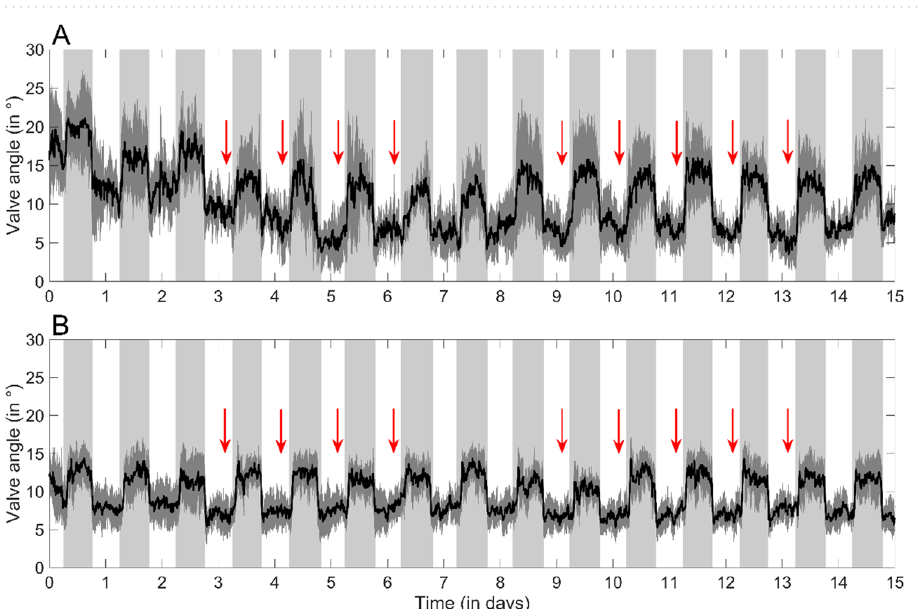
Figure 4. Scallops decrease valve angle during pile driving events, with no acclimation over long (i.e., days) and short (i.e., minutes to hours) time. Responses (valve angle, in degrees) from tagged scallops to PD at two different time scales at the near site: ( A ) Mean changes in valve angle in response to daily PD (black lines) compared to the preexposure sequence (dashed line). The red line highlights the mean of 9 days of PD exposure. Note the quick and dramatic decrease in valve angle during the first minute of PD exposure. Blue area covers the time period highlighted in B. ( B ) Synchronized data from one tagged scallop placed at the near site, with the accelerometer (top) and magnetometer (bottom). Each strike from the impact hammer (stars) was detected by the tagged scallop, which responded by partially closing its valves (shaded area).